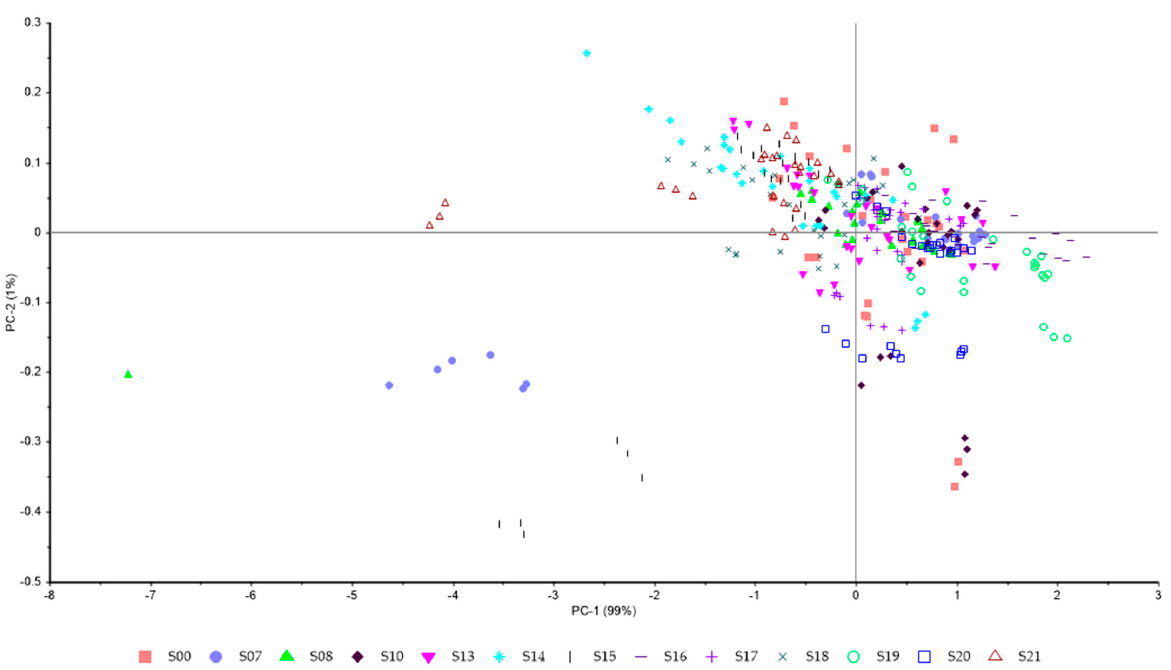
Figure 3. Principal component analysis (PCA) constructed from the NIR absorbance values through the bottle for Shiraz vertical vintages, x-axis representing the principal component one (PC1), while y-axis representing principal component two (PC2). Abbreviations are shown in Table 1.